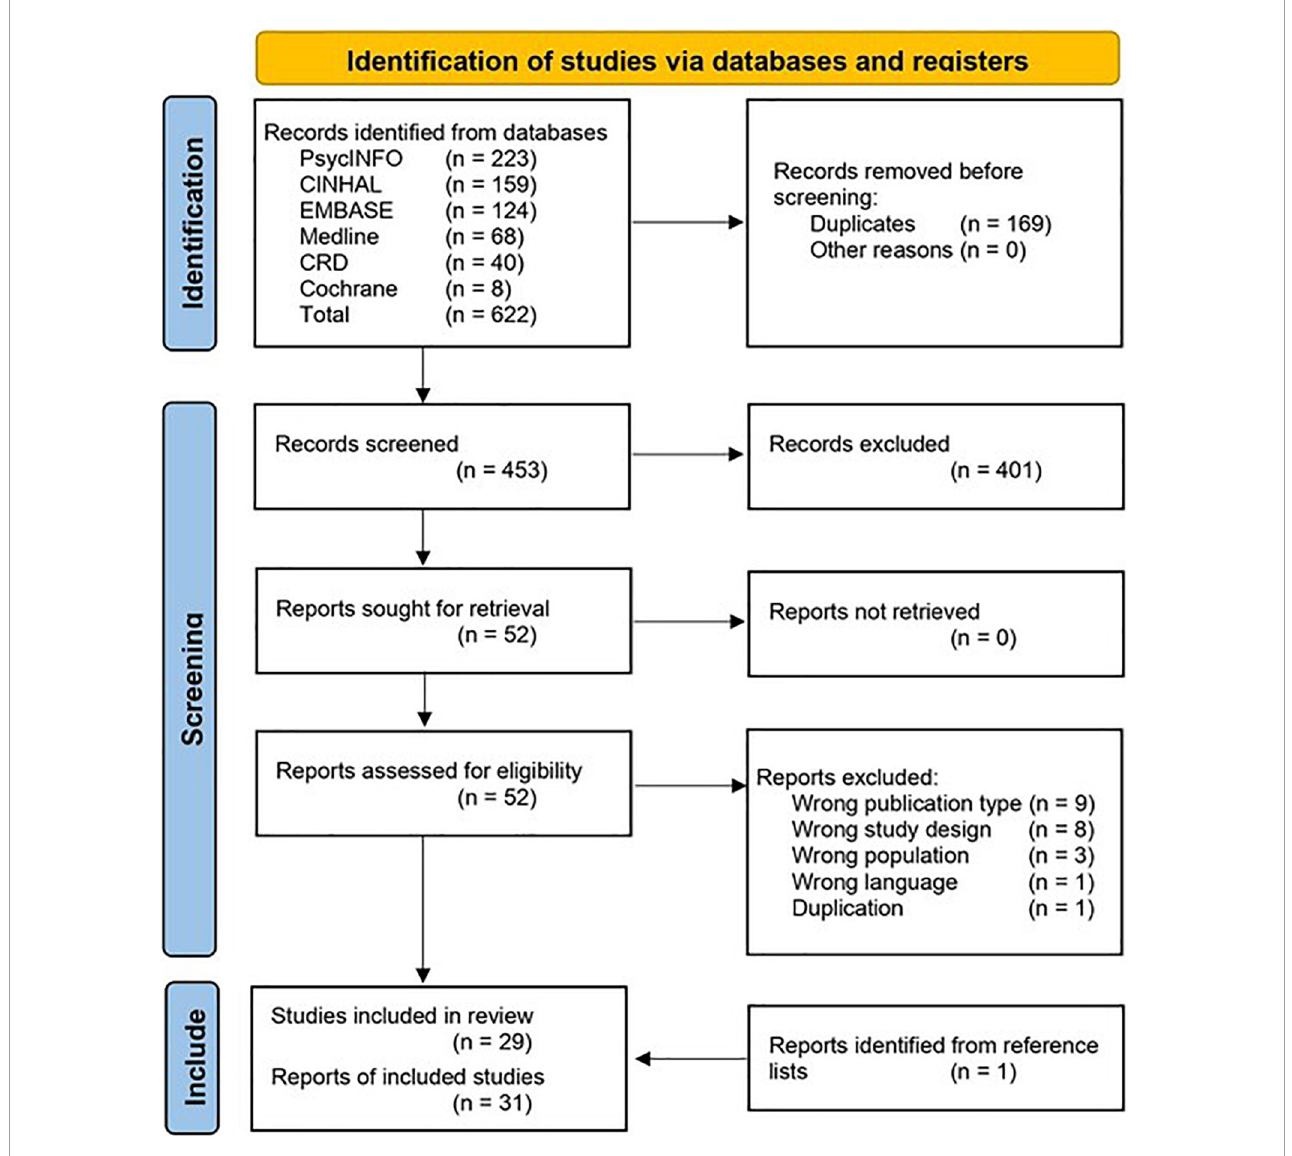
FIGURE1 PRISMA flow diagram of study identification, adapted from